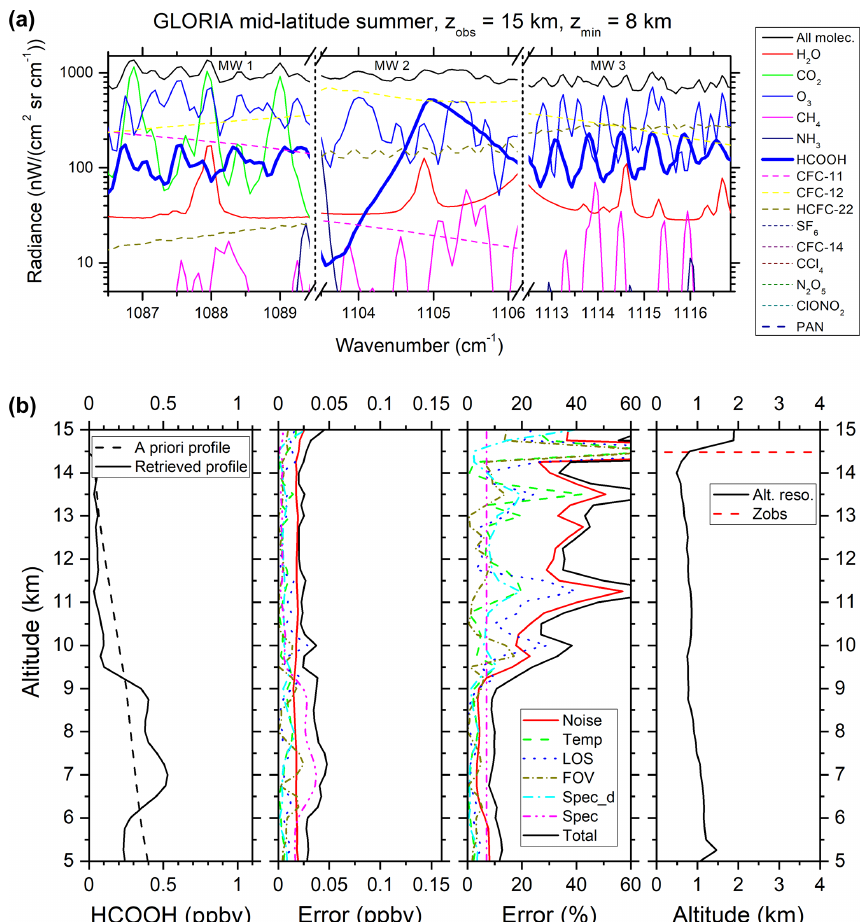
Figure 4. Simulated limb emission spectra for three microwindows within the HCOOH ν 6 band centred near 1105cm − 1 for a tangent altitude of 8km (a) and the error budget for a HCOOH vertical profile obtained on 13 September 2017 at 16:55UTC (b) . Annotation as per Fig. 2.